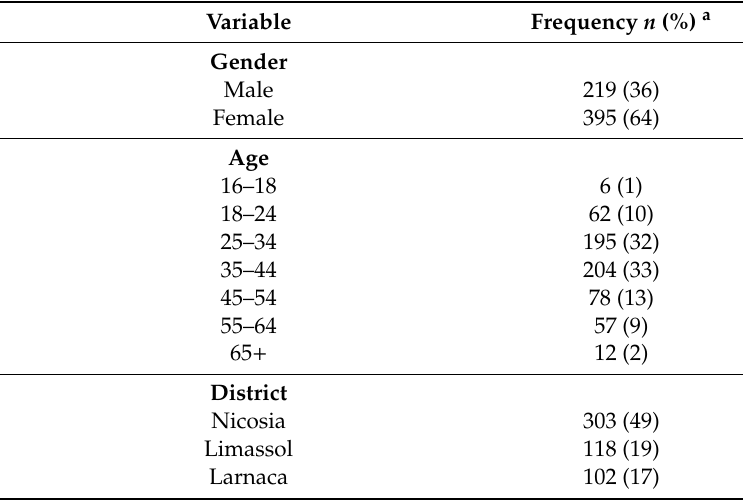
Table 1. Socio-demographic characteristics of